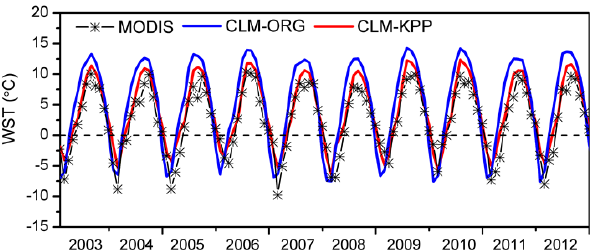
Figure 7. Time series over the period of 2003 through 2012 of monthly WST observations from MODIS (black starred line) and simulations with CLM-ORG (blue line) and CLM-KPP (red line) (unit: ◦